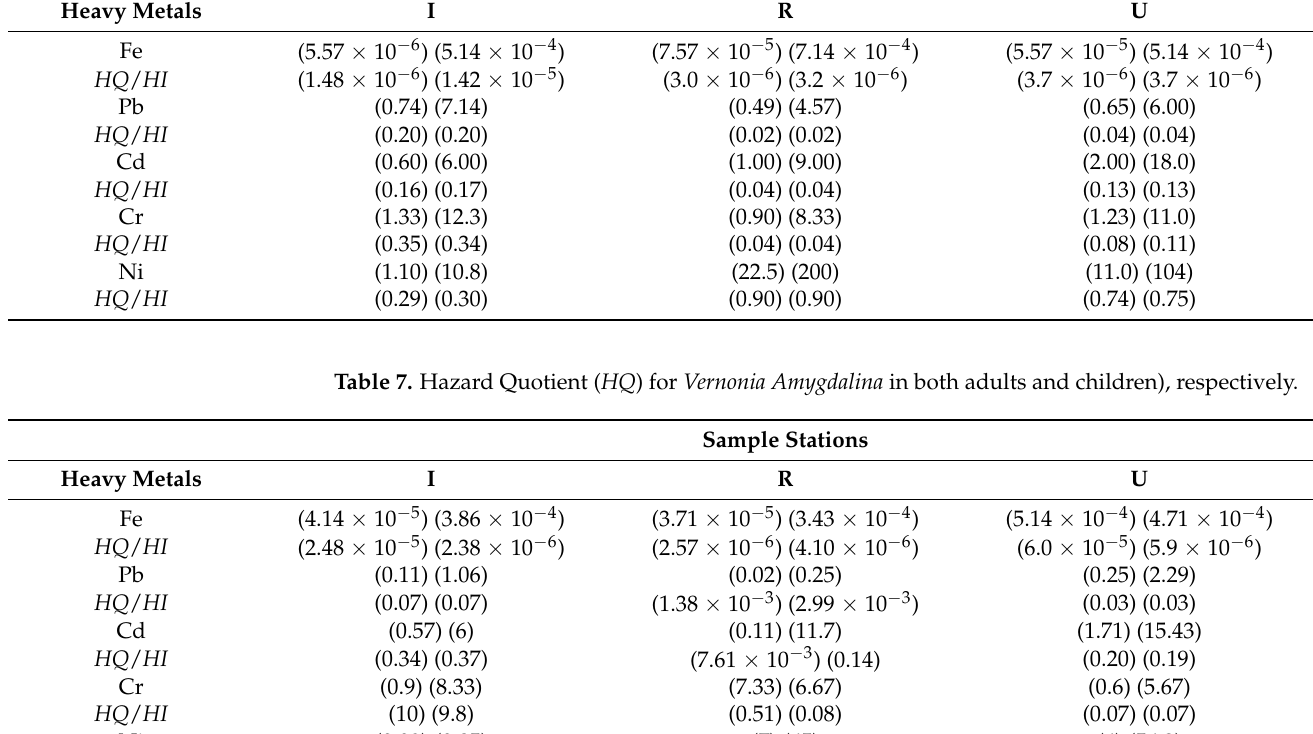
Table 6. Hazard Quotient ( HQ ) for both adults and children in soils. Sample Stations